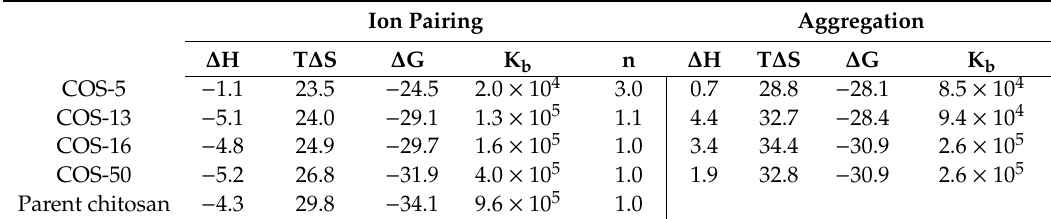
Table 3. Thermodynamic parameters of the siRNA / COS complexation evaluated by isothermal titration calorimetry (ITC) at T = 298 K with a multiple non-interacting sites (MNIS) model by considering two contributions, the ion pairing throughout the titration and the aggregation at initial N:P ratios. Note that the aggregation step was observed with COS 5-13-16-50 but not with the parent chitosan